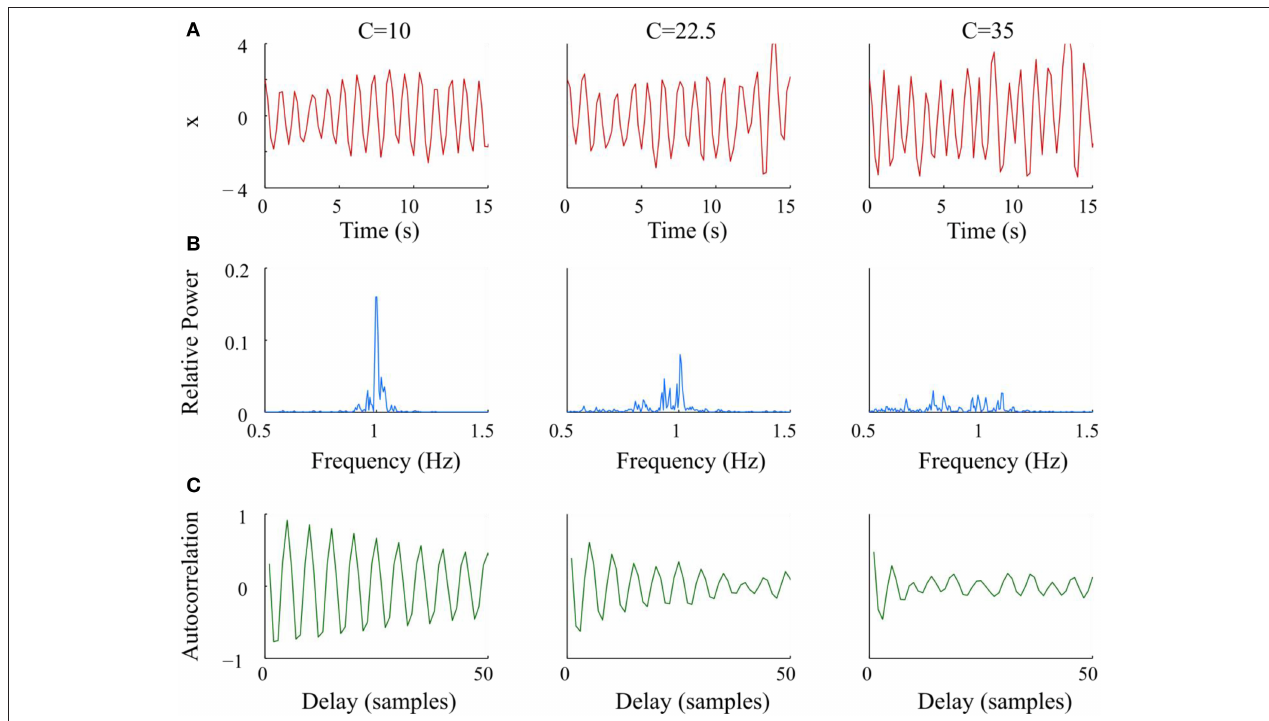
FIGURE 1 | Graphs and analysis of representative synthetic data sets with increasing noise ( C ) from left to right. (A) Simulated Van der Pol oscillator waveform at different values of C . (B) Periodograms had wider bandwidths and lower maxima of relative power as C increased. (C) Autocorrelation functions decayed faster and lost periodicity as C